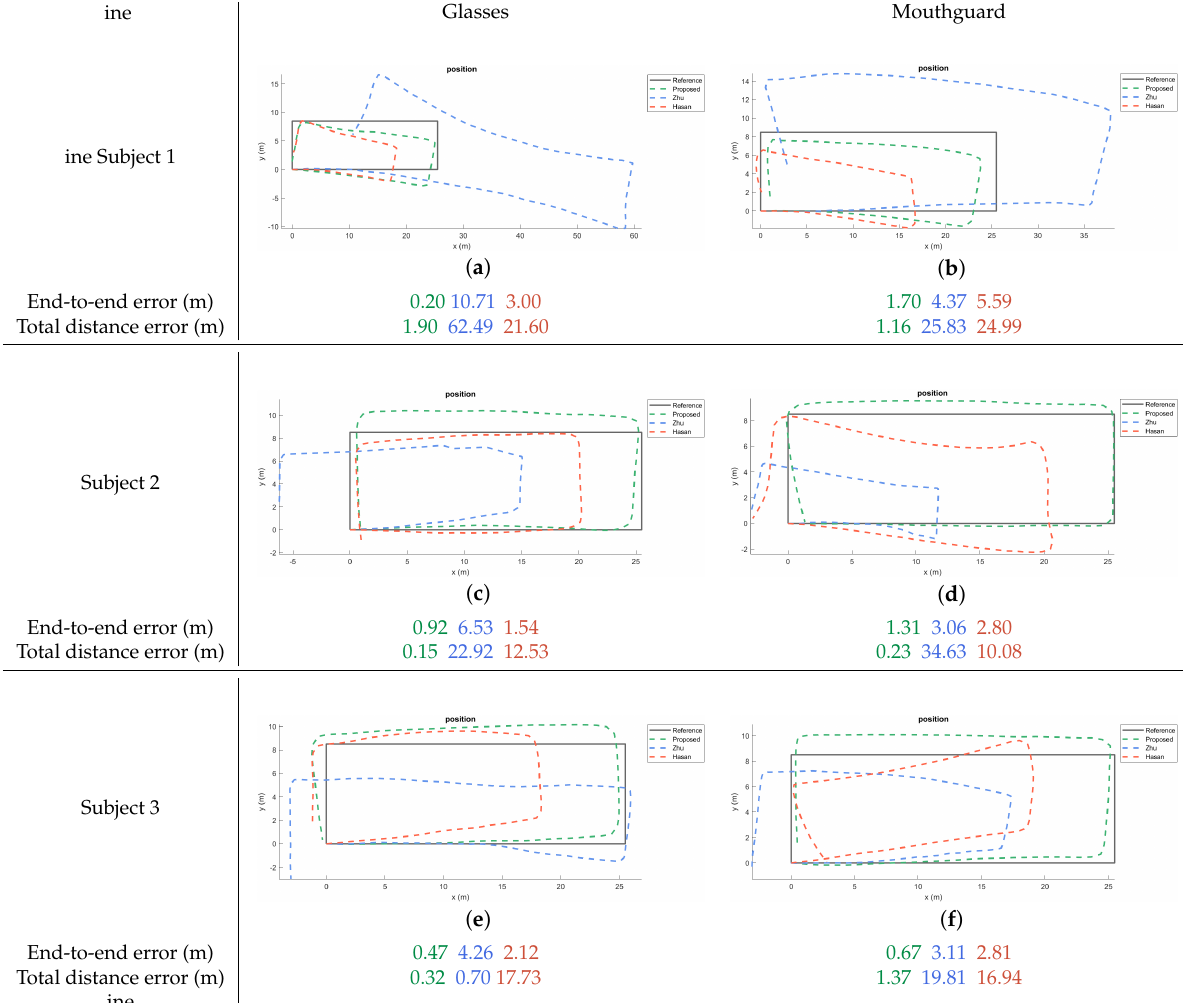
Figure 4. Estimated trajectories for the three methods plotted against the ground-truth. One of the measurements (randomly selected) of each subject is shown for each placement. The end-to-end error and total distance error (m) are shown in the sequence of proposed, Zhu’s, and Hasan’s